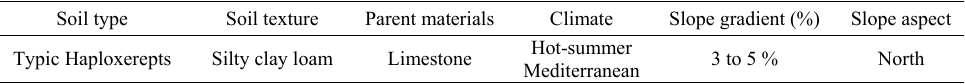
Table 1: The main characteristics of the sampling sites in the three land uses Soil type Soil texture Parent materials Climate Slope gradient (%) Slope aspect Hot-summer Typic Haploxerepts Silty clay loam Limestone Mediterranean